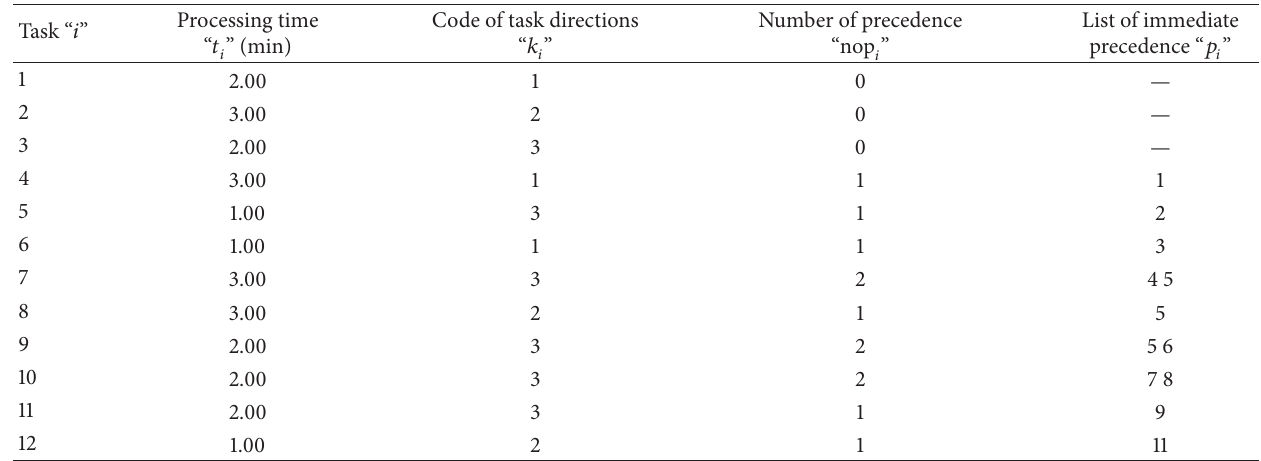
Table 13: Data of P12, CT = 5, 6, and 7 min